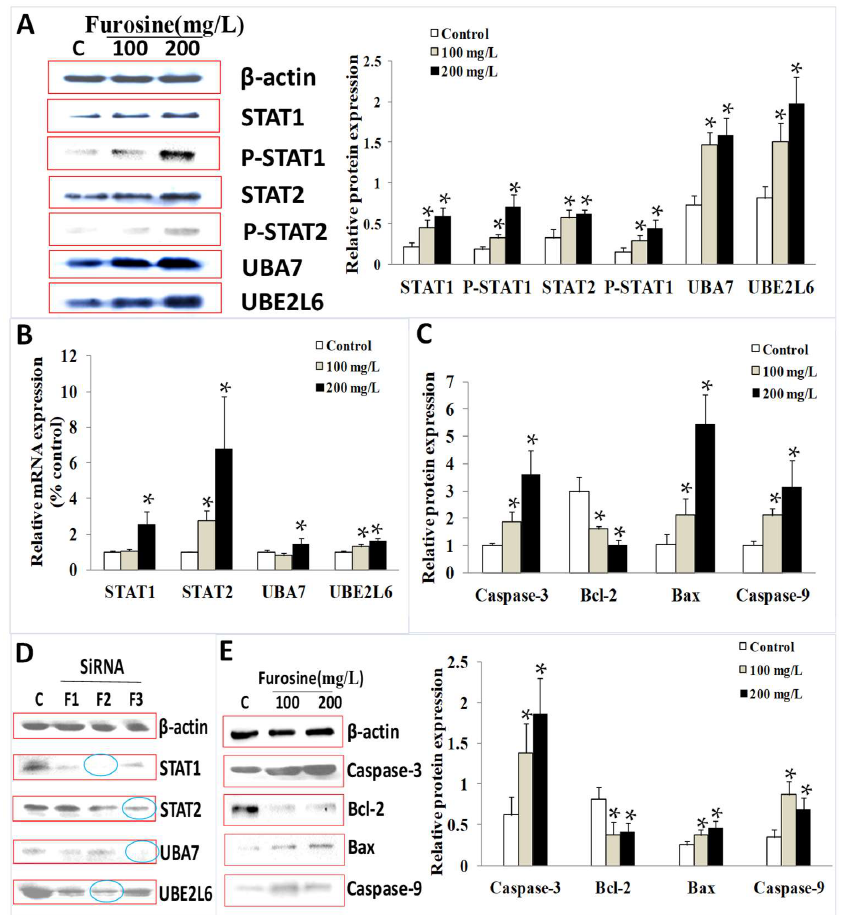
Figure 3. mRNA level and protein level of STAT1/2 , P-STAT1/2 , UBA7 , UBE2L6 , Caspase-3 , Bcl-2 , Bax , and Caspase-9 affected by furosine. ( A ) Furosine up-regulated expressions of STAT1/2 , P-STAT1/2 , UBA7 , and UBE2L6 at protein level; ( B ) Furosine up-regulated expressions of STAT1/2 , UBA7 , and UBE2L6 at mRNA level; ( C ) Furosine up-regulated expressions of Caspase-3/9 , Bax , and Bcl-2 at protein level; ( D ) Selection of high-efficient SiRNA fragment in HepG2 cells. Blue circle stands for the high-effeciency SiRNA fragments of each factor which would be chosen and utilized in Figures 4 and 5; ( E ) Furosine up-regulated expressions of Caspase-3/9 , Bax , and Bcl-2 at mRNA level. The values of biochemical indicators were represented as mean ± SD, * p < 0.05, compared with the control ( n = 3).